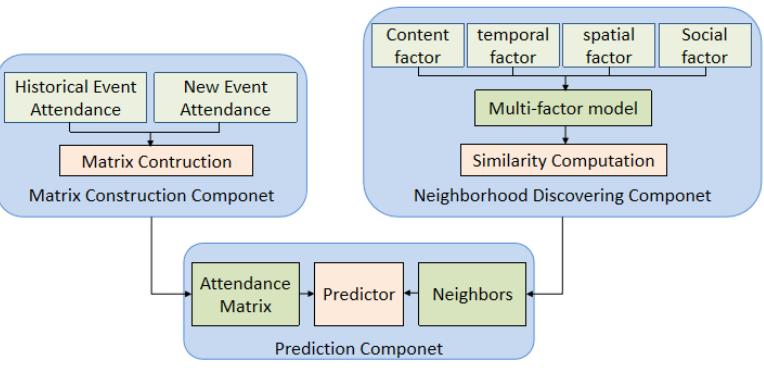
Figure 4. Framework of SVD-MFN